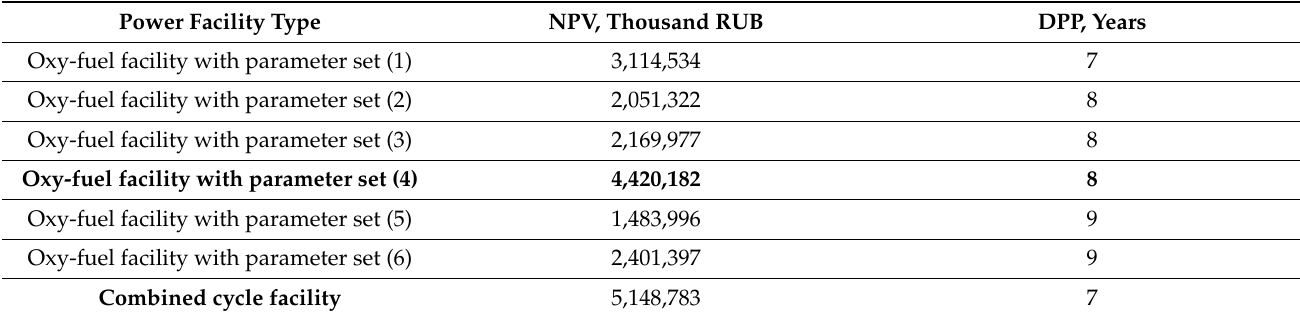
Table 8. Comparative financial efficiency analysis of oxy-fuel and combined cycle facilities.